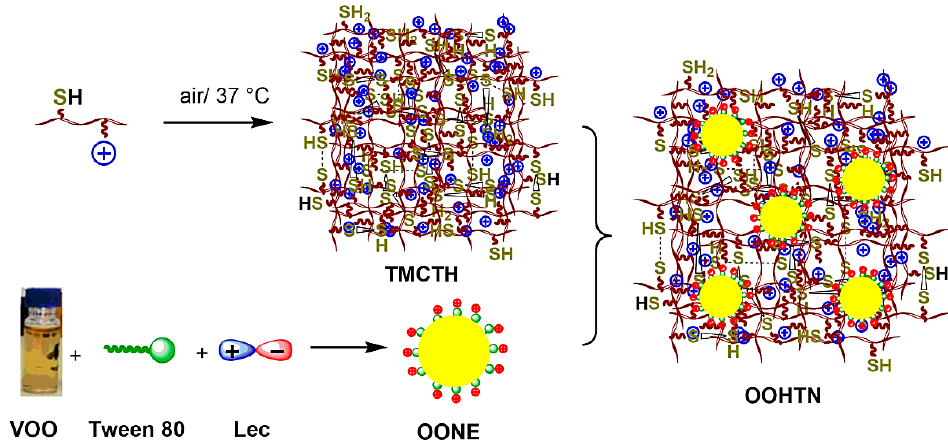
Figure 1. Formulation of OOVE, TMCTH, and OOHTN.